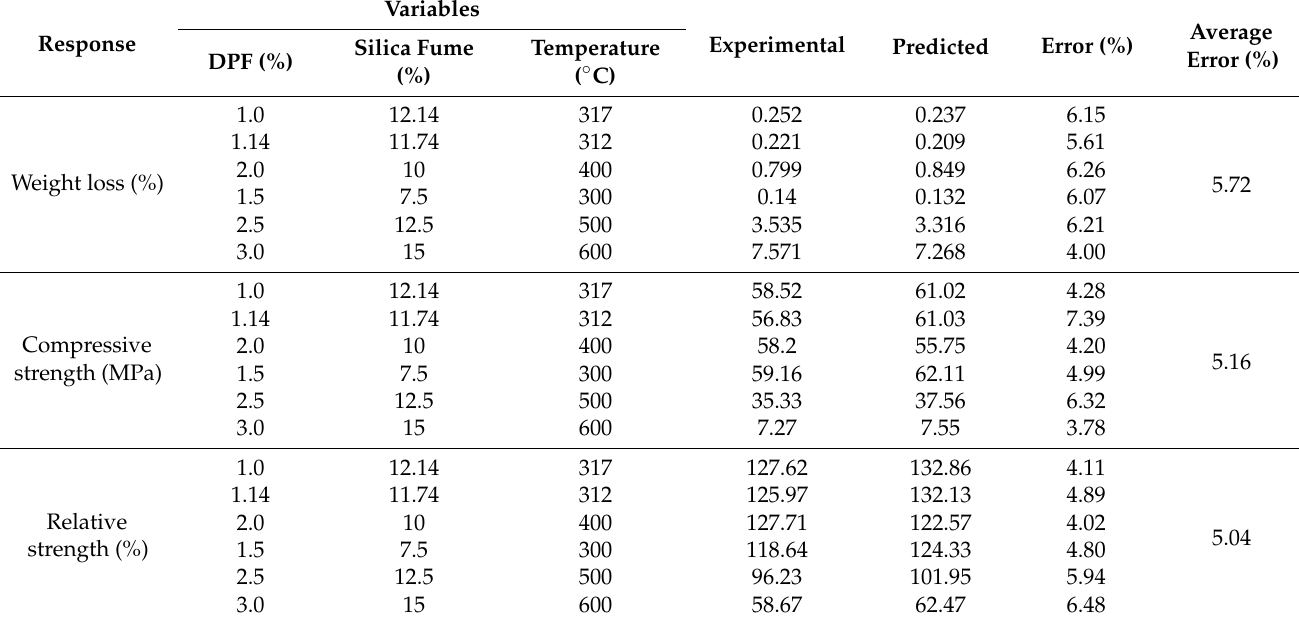
Table 10. Models’ experimental